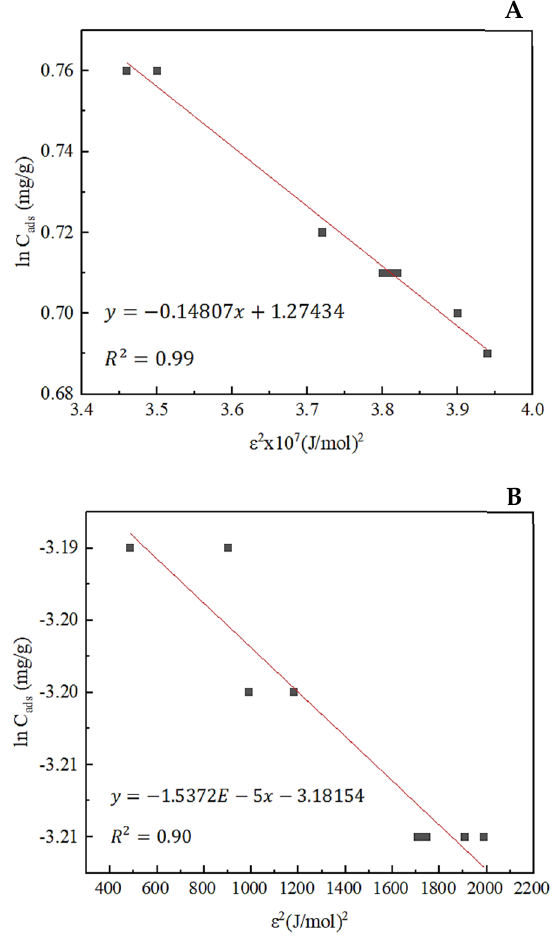
Figure 13. Dubinin–Radushkevich adsorption isotherm of ( A ) total rare earth elements and ( B ) thorium onto zeolite.